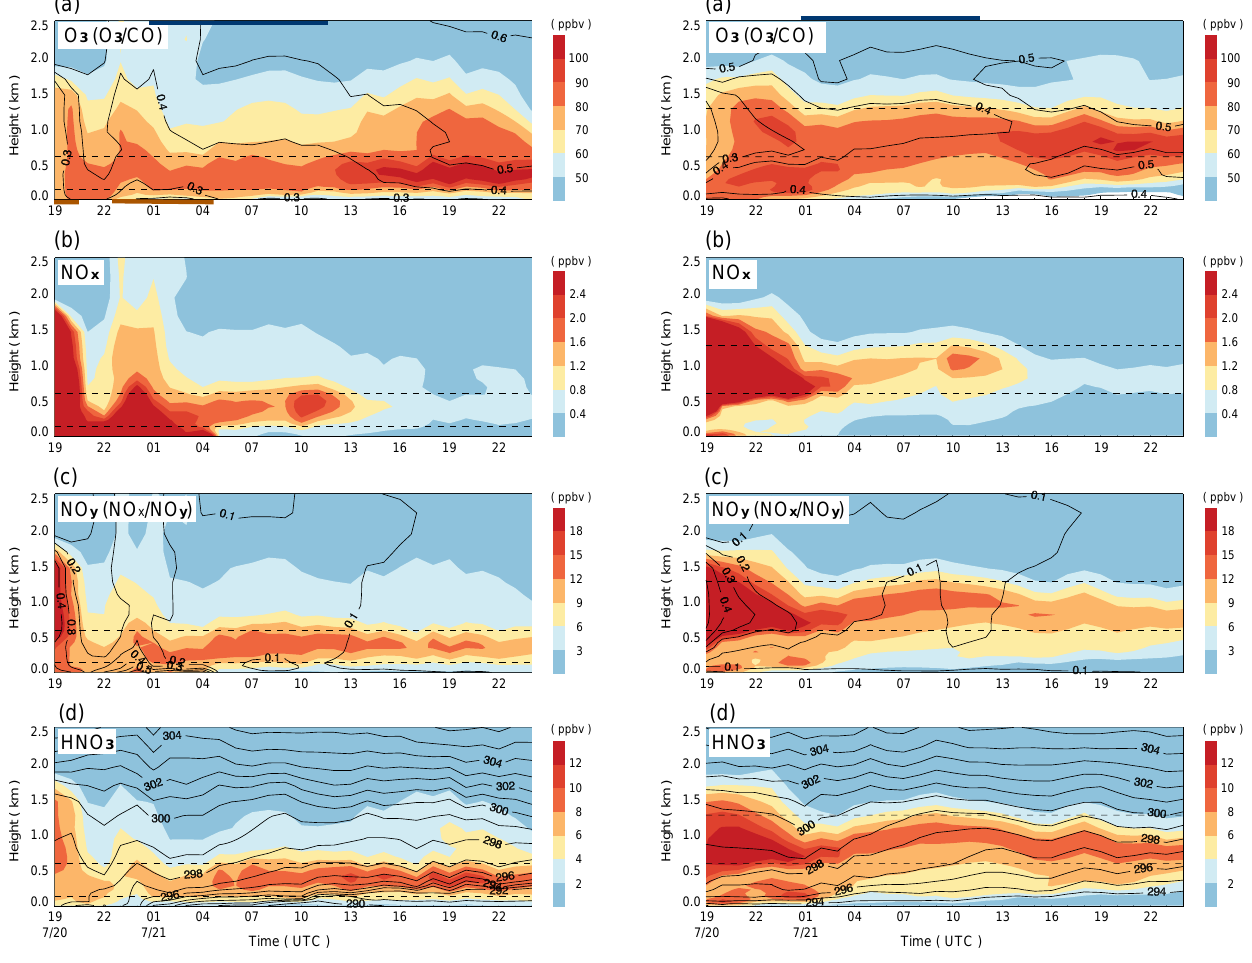
Fig. 12. Time-height plots of simulated (a) O 3 and O 3 /CO, (b) NO x , (c) NO y and NO x /NO y , and (d) HNO 3 and potential temper- ature along the forward trajectory of the lower-level NYC plumes (dashed lines) denoted in Fig. 10. Upper and lower thick lines in (a) denote nighttime period and transport over land, respectively.